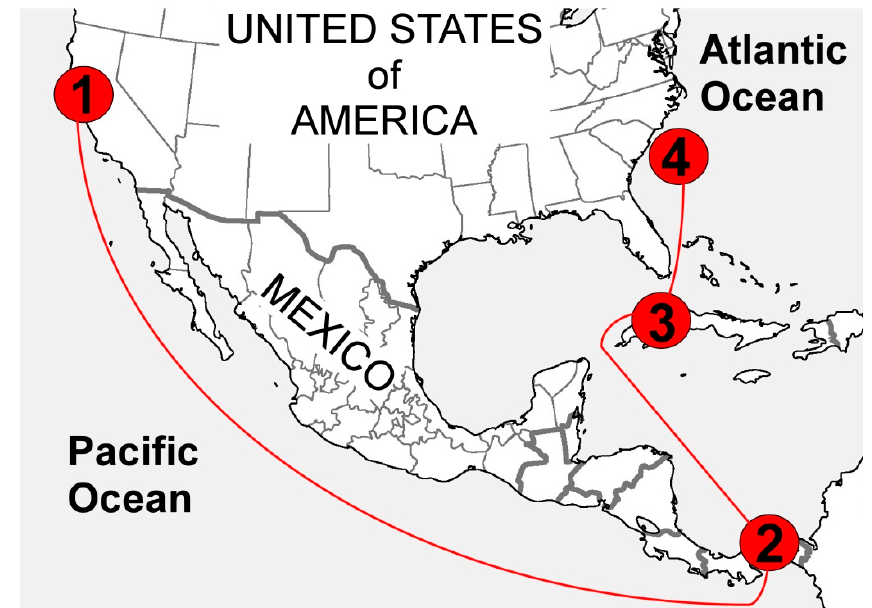
Figure 1. Map of the route of the SS Sonora from San Francisco (1), to Panama (2), where passengers embarked on the SS Central America for Cuba (3) with an ultimate destination of New York. The ship sank in the Atlantic Ocean on September 12, 1857 during a hurricane off the coast of the Carolinas (4).